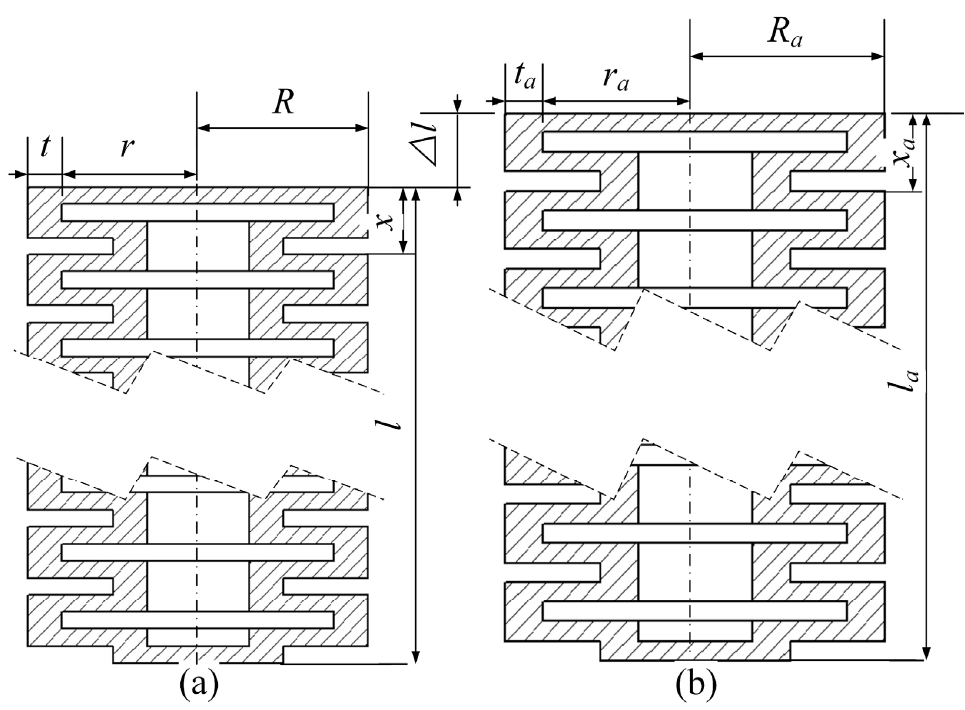
Figure 2. Cross section broken view of the bellows actuator in the initial state and deformed state ( a ) Initial state; ( b ) Deformation state.